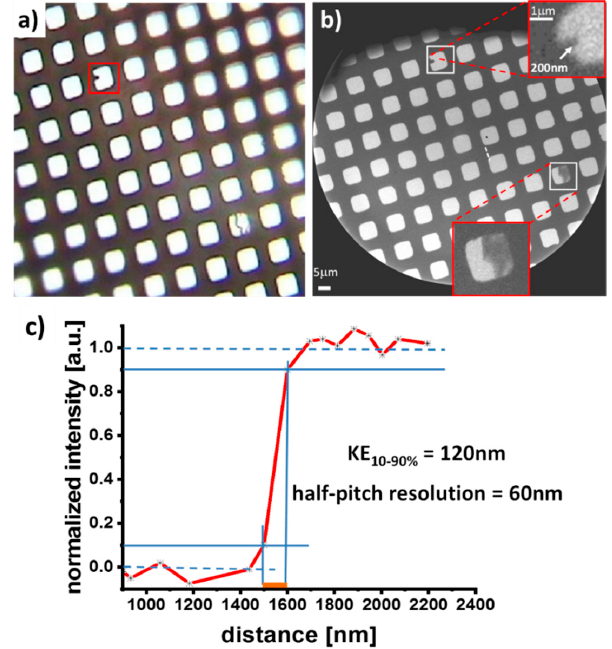
Figure 10. ( a ) Optical and ( b ) SXR image of a #2000 TEM copper mesh. Insets in ( b ) shows